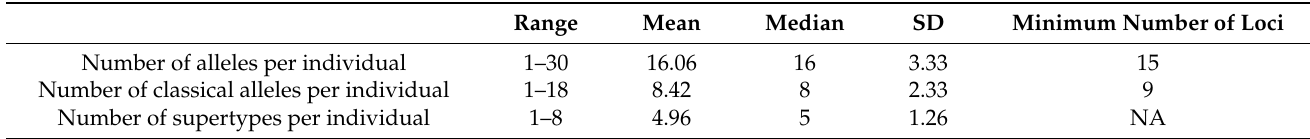
Table 1. MHC diversity of MHC Class I exon 3 in Godlewsiki’s Bunting. Range Mean Median SD Minimum Number of